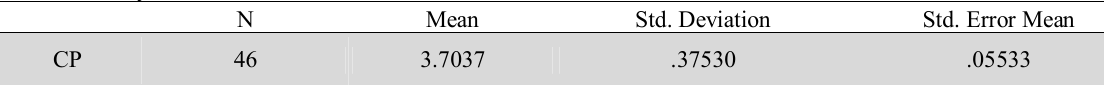
The summary of some basic